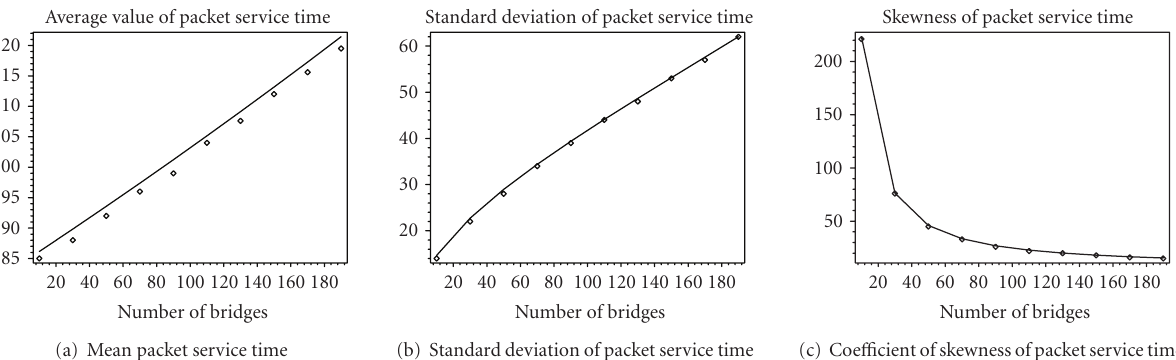
Figure 7: Moments of packet service time. Analytical results are shown as lines and simulation results are shown as points.